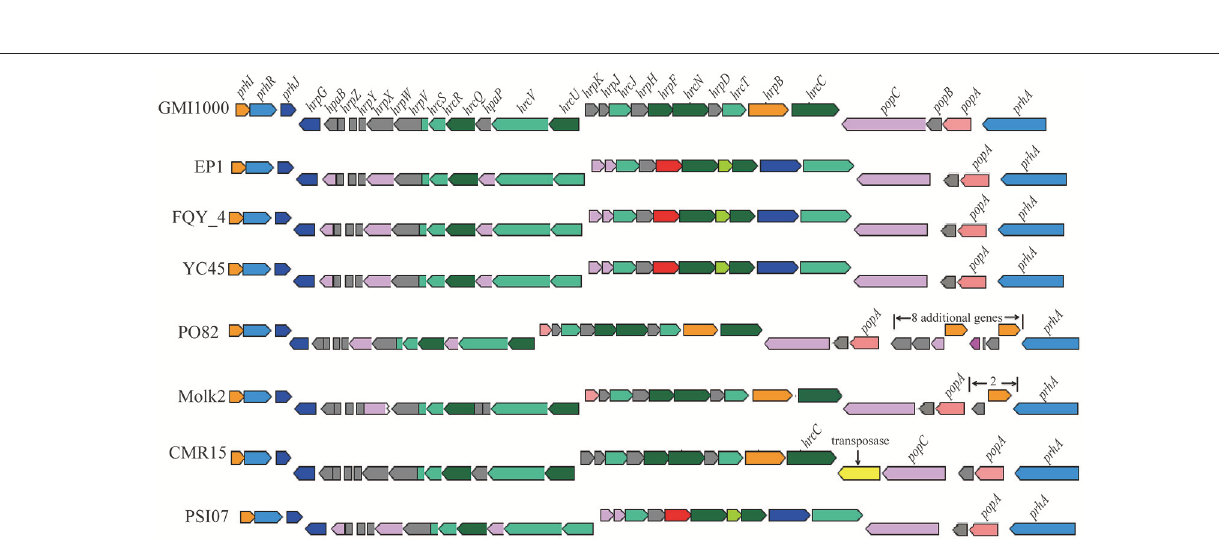
Frontiers in Microbiology | www.frontiersin.org